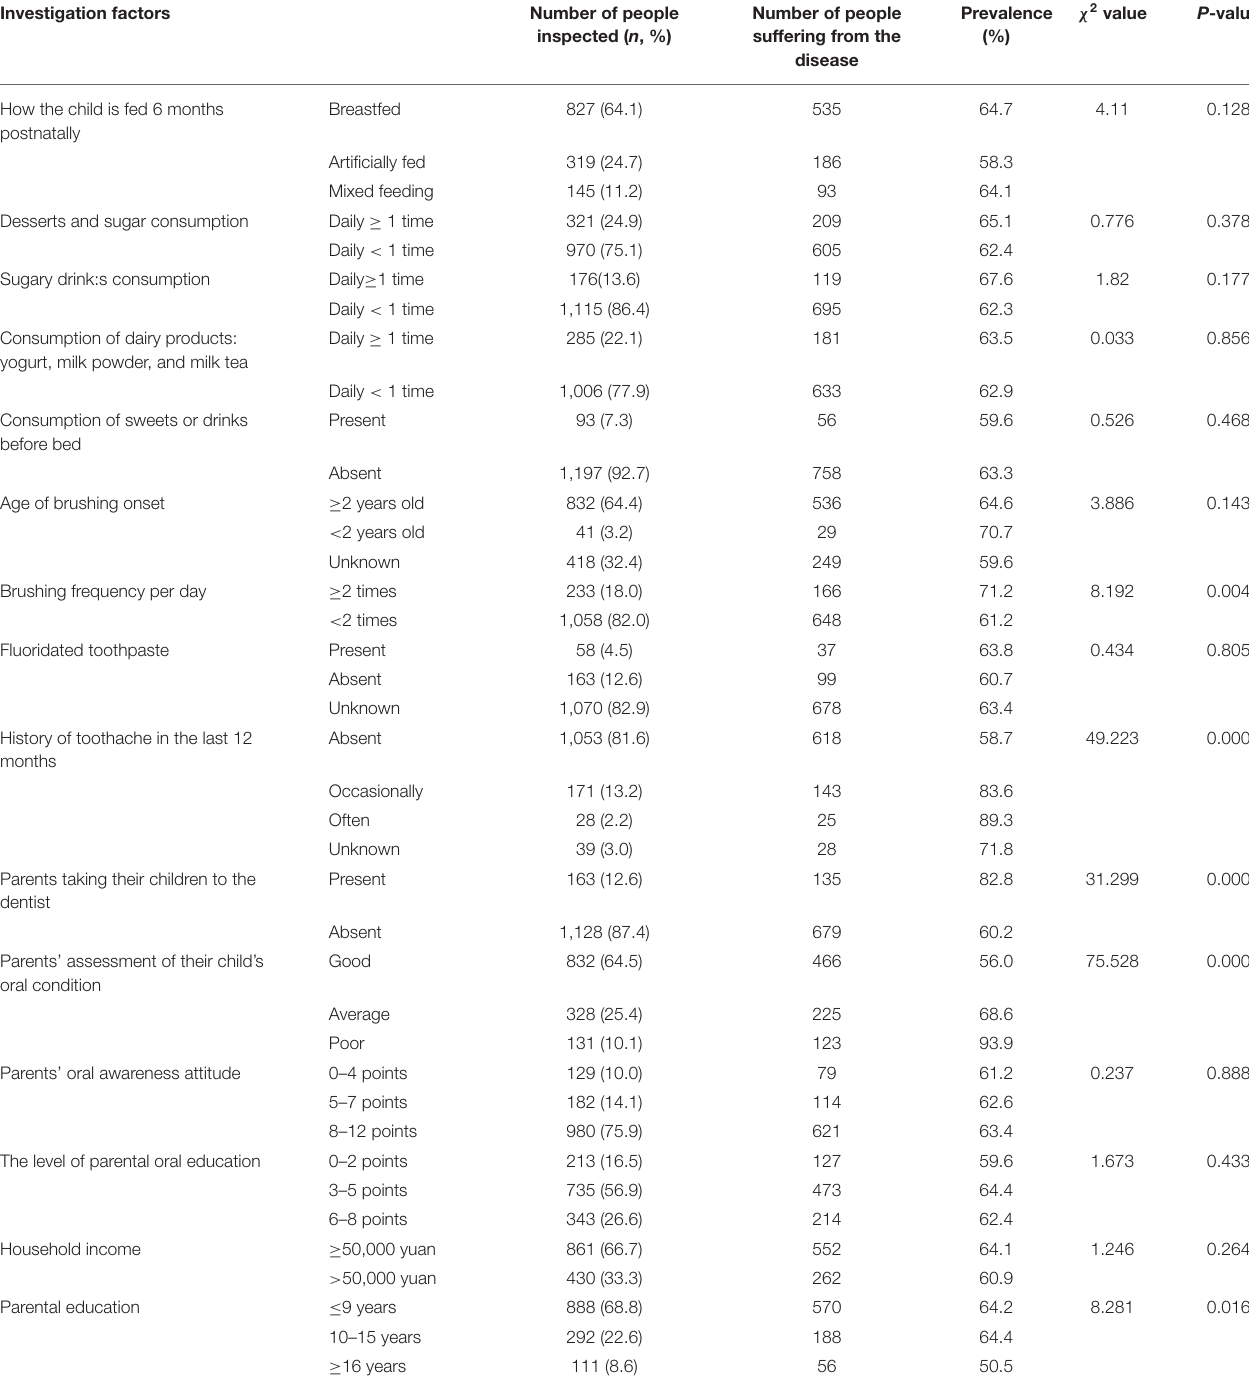
TABLE 2 | A single-factor analysis of factors associated with early childhood caries (ECC) in children aged 3–5 years in Guizhou Province. Investigation factors Number of people